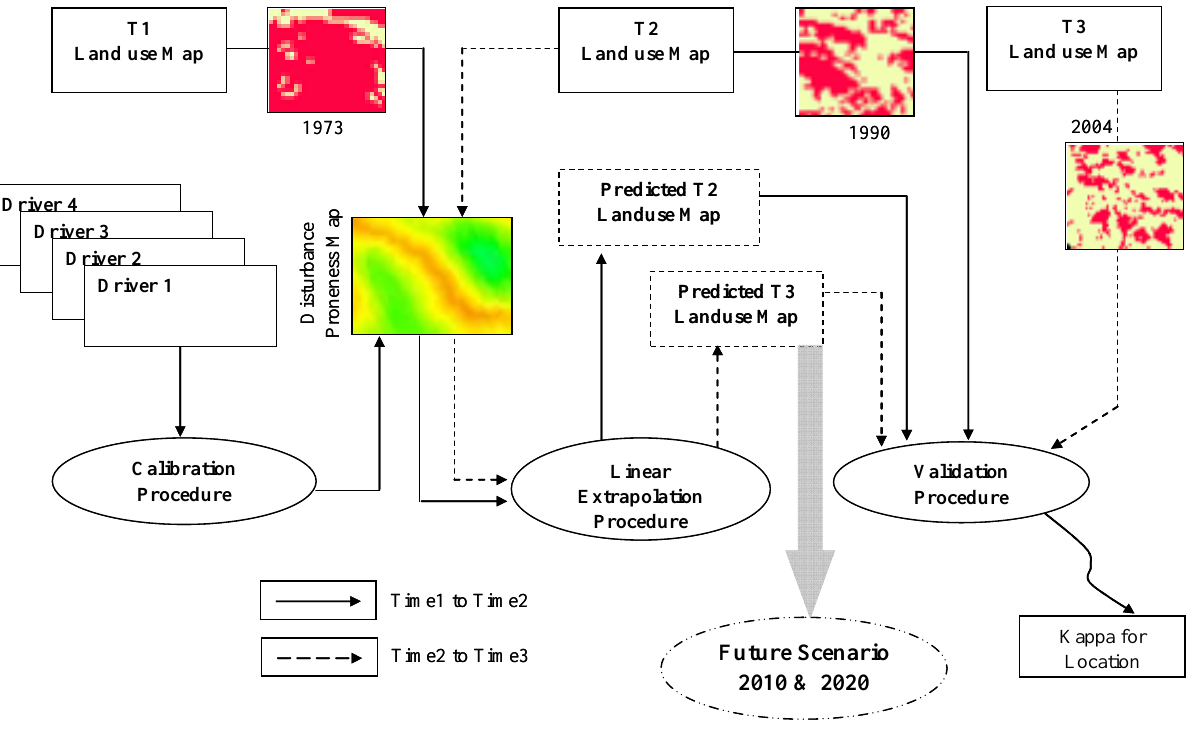
Figure 4. GEOMOD based modelling of evergreen forest change using spatial drivers, extrapolation and validation procedure for the future evergreen forest scenario in